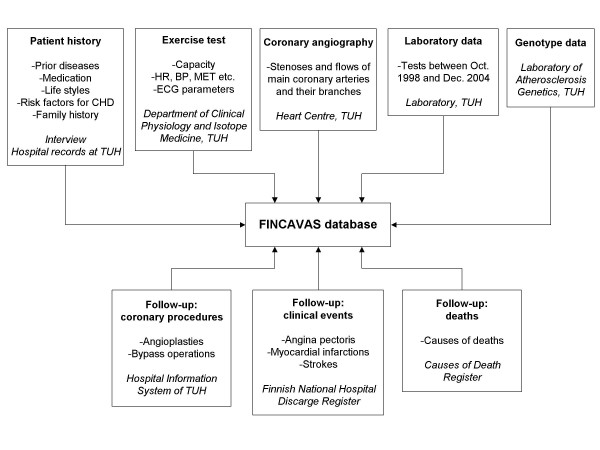
Data sources utilised in the present study. CHD, coronary heart disease; HR, heart rate; BP, blood pressure; MET, metabolic equivalent; ECG, electrocardiogram; TUH, Tampere University Hospital.